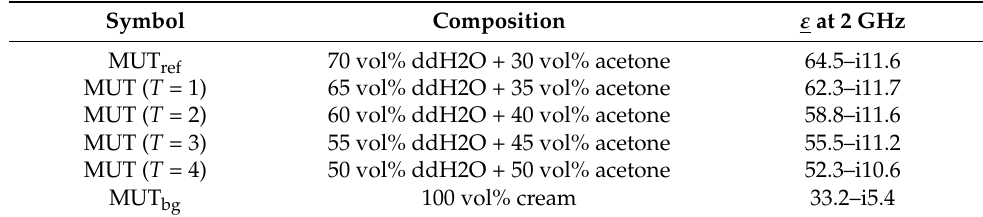
Figure 3. Measurement setup for preliminary investigations towards tissue temperature estimation. MIMO stands for multiple input multiple output, UWB for ultra-wideband and MUT for material under test, index in MUT bg stands for background. Table 1. Materials under test used in the